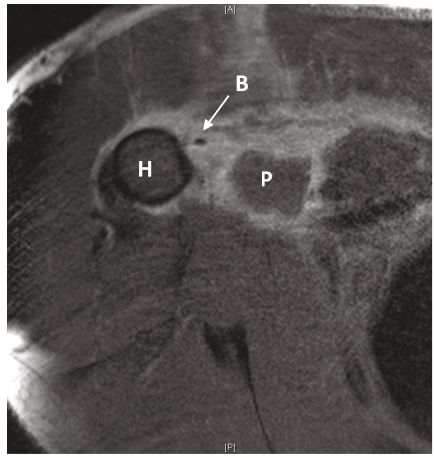
Figure 2: Axial MRI image. H: humerus; P: pectoralis major; B: biceps